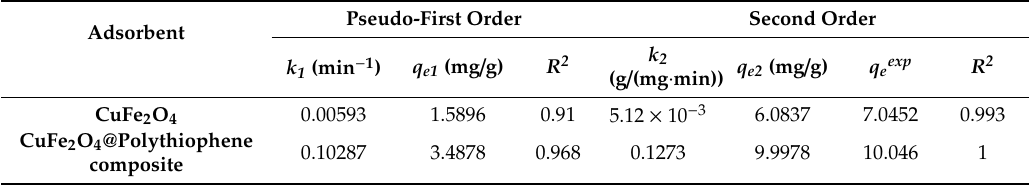
Figure 6. E ff ect of contact time on Hg(II) removal from aqueous solution ( A ) CuFe 2 O 4 and ( B ) CuFe 2 O 4 @Polythiophene composite [Conditions: Initial conc. of Hg(II) solution = 10 mg / L, adsorbent dose = 0.05 g, pH = 6, volume of Hg(II) solution = 50 mL). Table 2. Adsorption kinetics parameters achieved using pseudo first order and second order